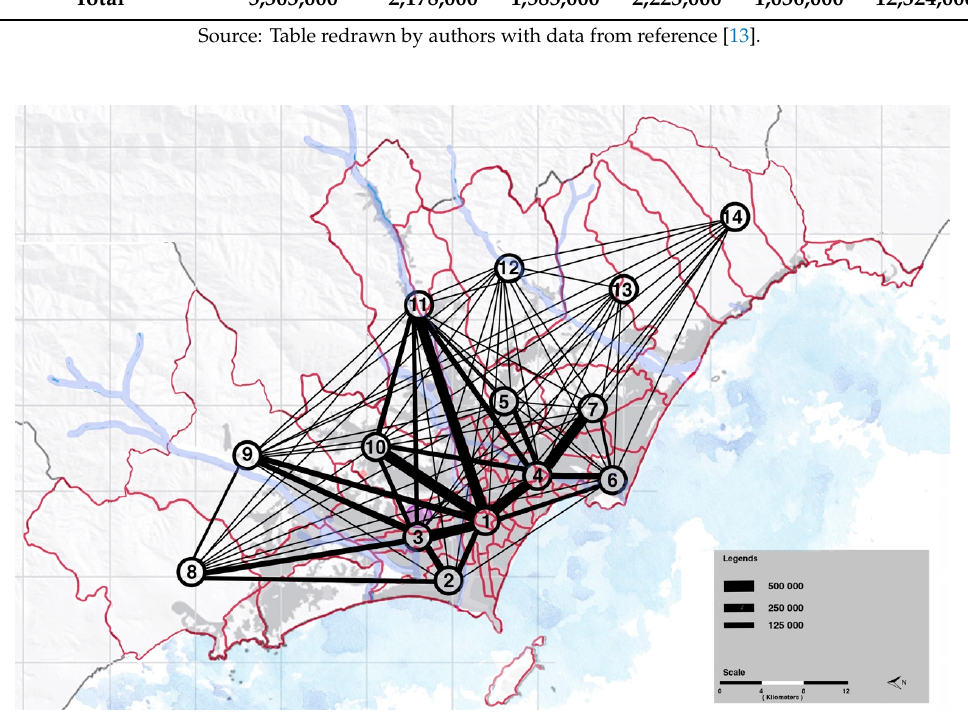
Figure 19. Desire lines according to the different areas of Lima. All transport modes included. Source: Reference [39]. Map by authors, 2018.